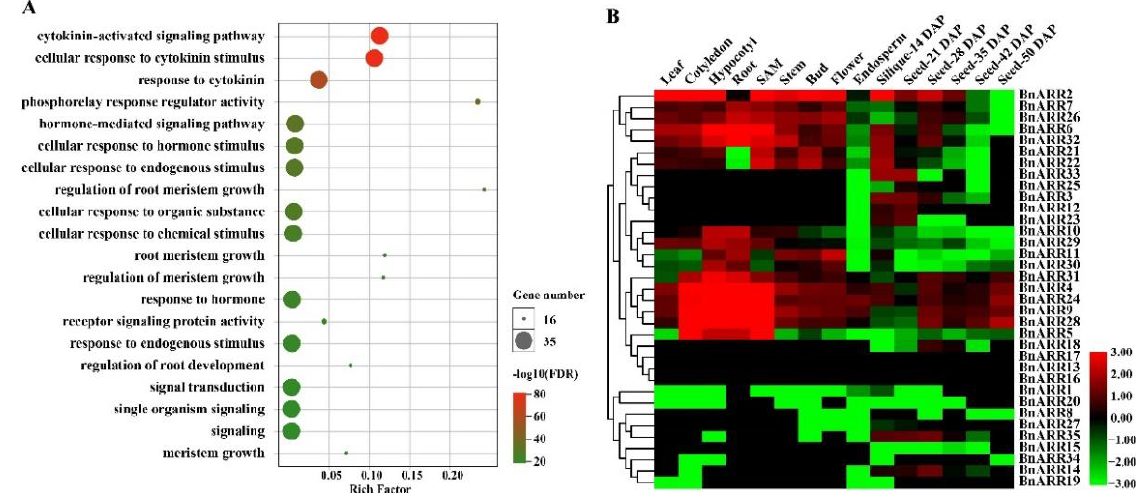
Figure 7. GO enrichment and spatiotemporal expression pattern of type-B ARRs in B. napus . ( A ) The top 20 GO terms enriched by BnARRs . Rich factor means the ratio of BnARR gene number to transcript number in each term. ( B ) Heatmap of BnARRs expression with log 10 FPKM. DAP, days after pollination; SAM, shoot apical meristem.